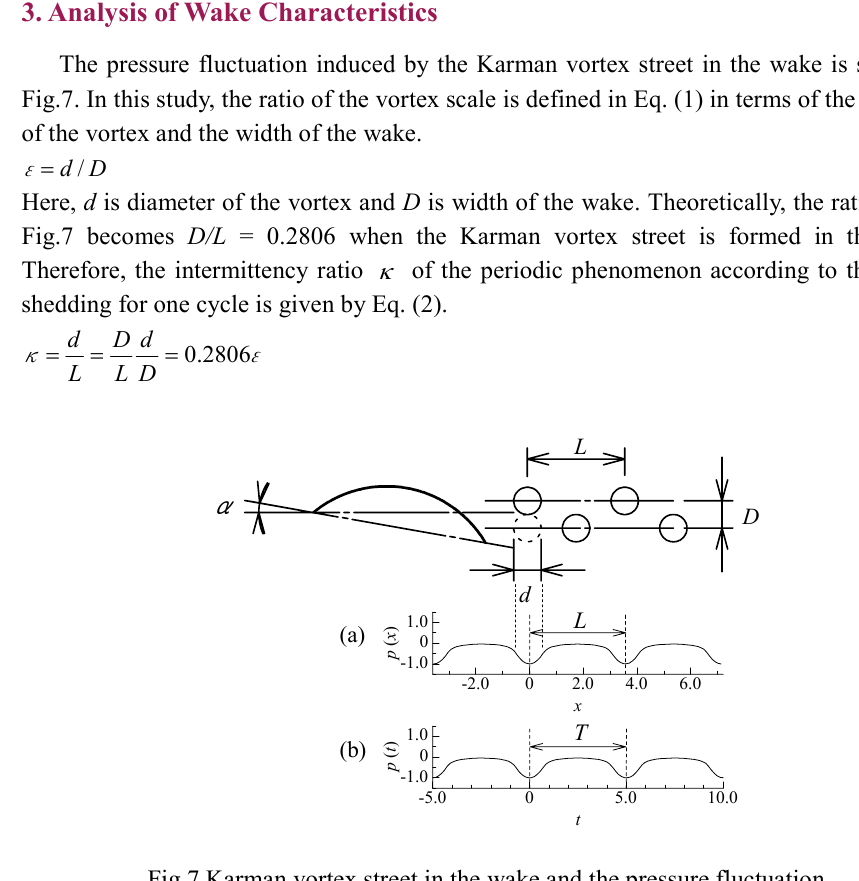
Fig.7 Karman vortex street in the wake and the pressure fluctuation